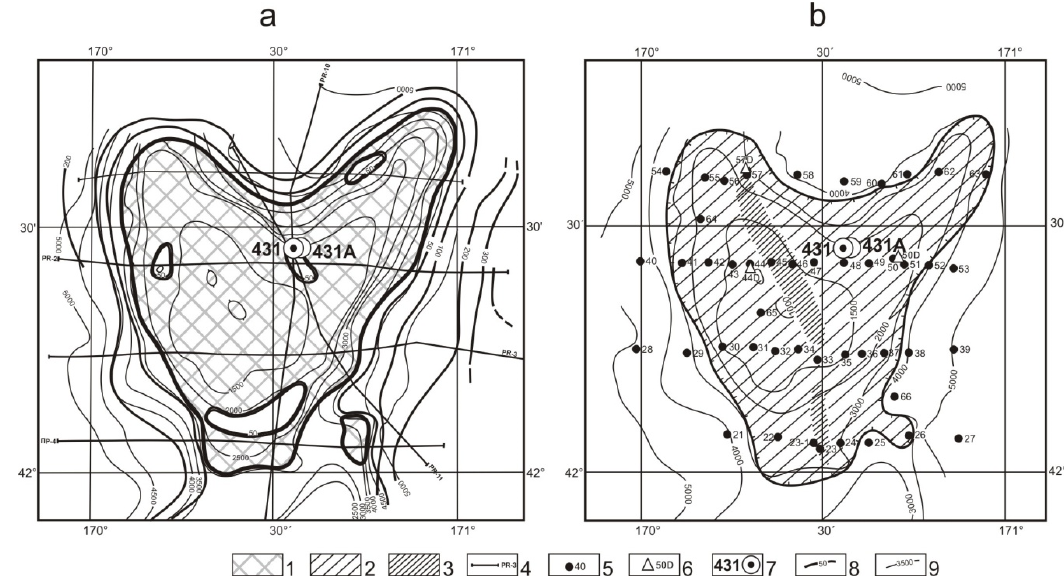
Figure 2. Sedimentary sheath thickness ( a ) and ferromanganese deposits location ( b ) within the Y¯omei Guyot[18,22]: 1—acousticbackground, 2—locationofFe-Mndeposits, 3—areawithmaximumthickness of Fe-Mn deposits, 4—seismic reflection track lines, 5—clamshell sediment sampler stations and